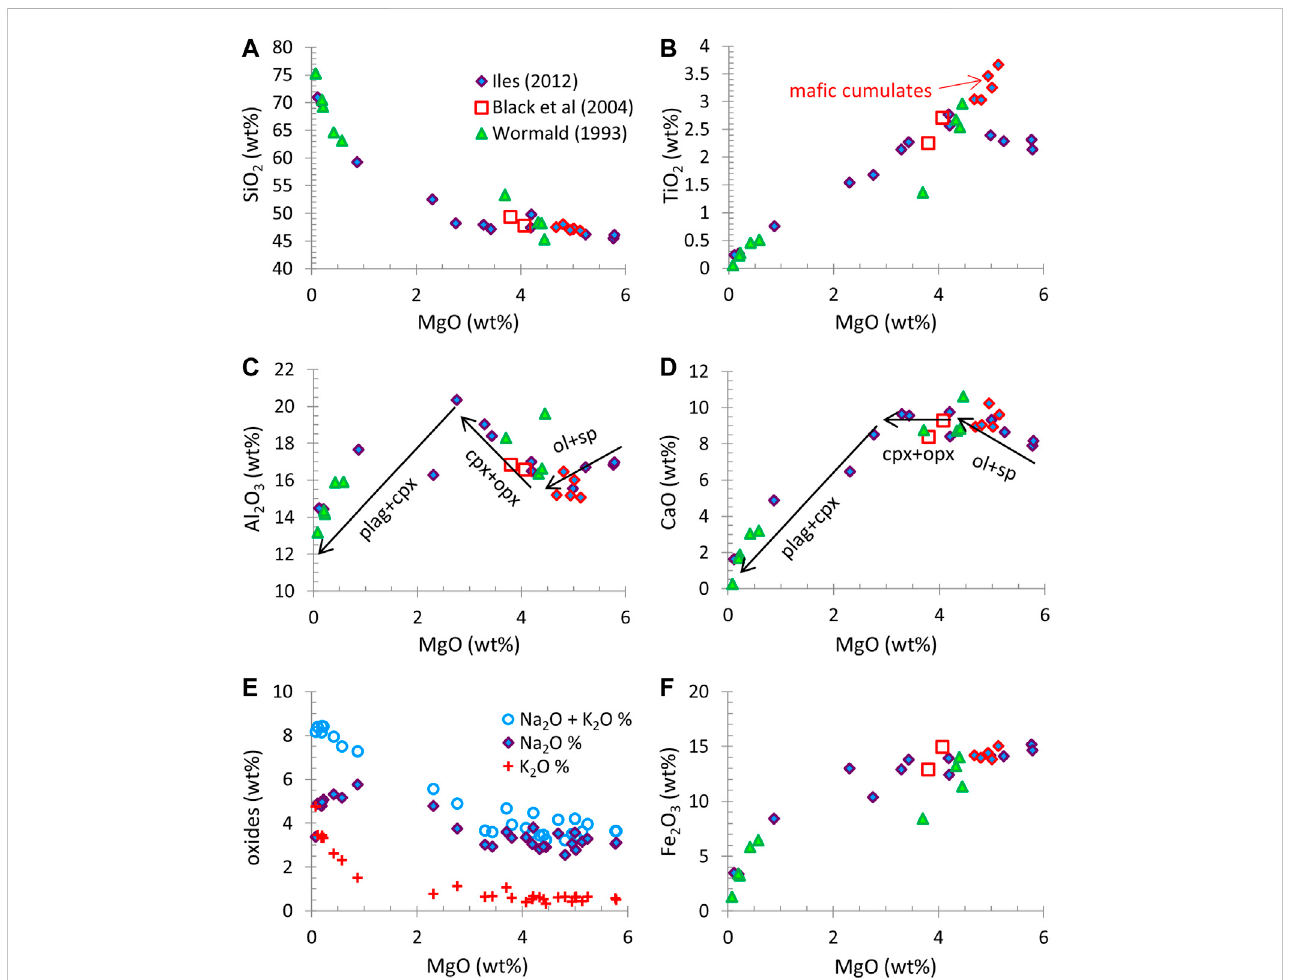
FIGURE 3 Variation diagrams for all Wallundry Suite samples, with elemental oxides plotted against MgO. (A) SiO 2 varies little for most of the MGD samples, but increases markedly with decreasing MgO for the felsic samples. (B) TiO 2 shows two trends that intersect at ~4 wt% MgO. (C) With decreasing MgO content, Al 2 O 3 begins to increase sharply at ~4 wt% MgO, then decreases from ~3 wt% MgO. As for Al 2 O 3 , (D), (E) and (F) show that ~3 wt% MgO marks an in fl ection point for many major elements (Ca, Na, Fe). The trend in K 2 O is similar to that of SiO 2 . The fi ve samples with highest TiO 2 are shown using a different symbol(diamondswithaheavierredoutline)andarebelievedtorepresentpyroxene-richcumulaterocks.Thearrowsonpanel (D) illustratethegeneralshape of a possible liquid line of descent and are labelled with the main phases believed to control the fractional crystallisation assemblage (see text for